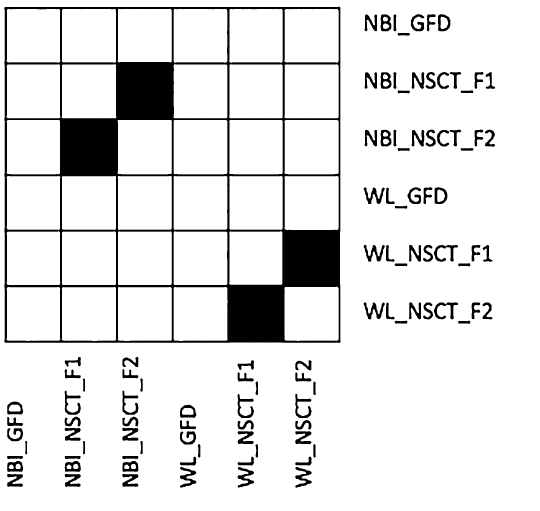
Figure 5. Feature